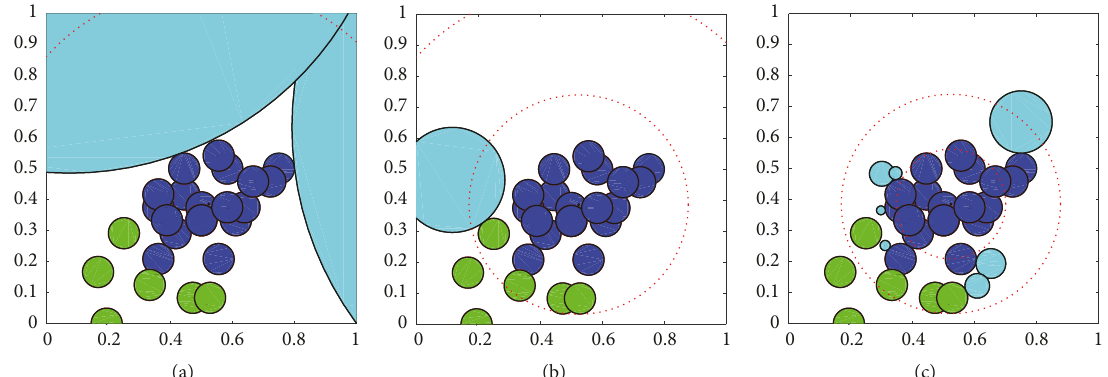
Figure 9: Limited scopes and generations of candidate detectors (based on the cluster of blue filled circles).